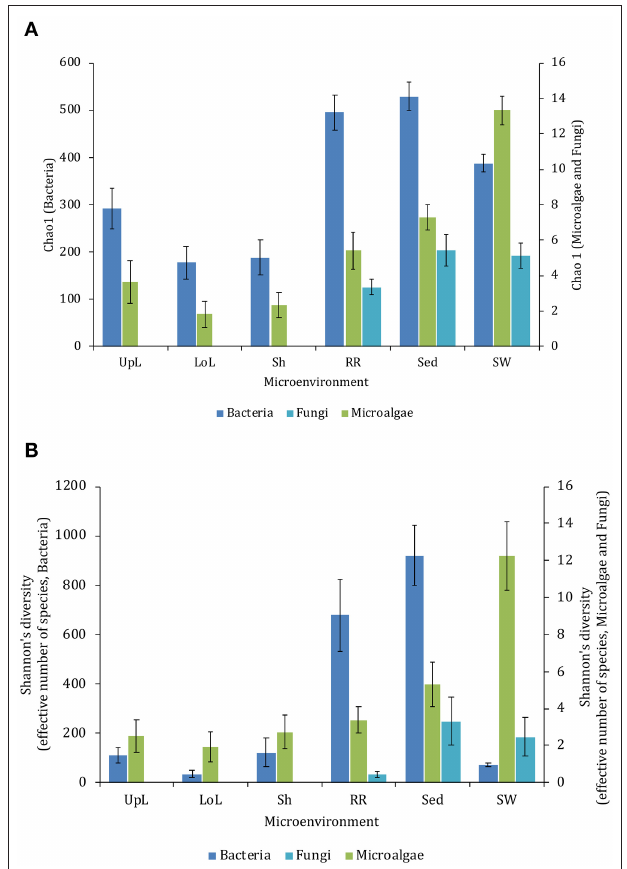
FIGURE 2 | Microbial mean alpha diversity across seagrass microenvironments. Multiple comparisons between Chao1 diversity (A) and Shannon’s diversity index (B) , calculated for each taxa and microenvironment separately, were tested for statistical significance with Permutational Multivariate Analysis of Variance (PERMANOVA, Minkowski metric distance matrix and nested design). Mean values for each microenvironment are shown, and error bars reflect the standard error of the mean.